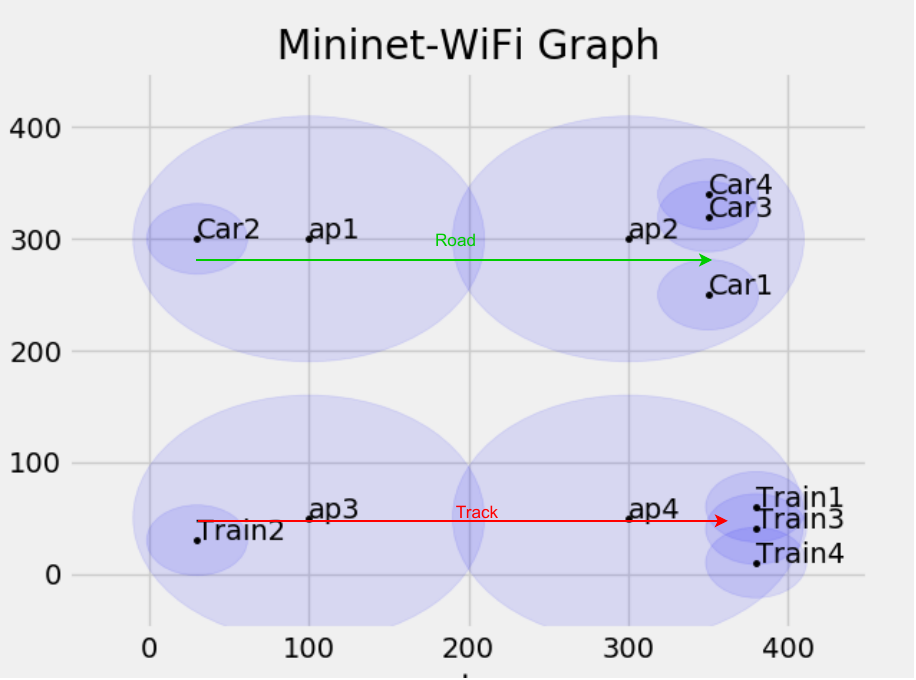
Figure 15. Hosts and access points after handover and moving: Mininet–WiFi